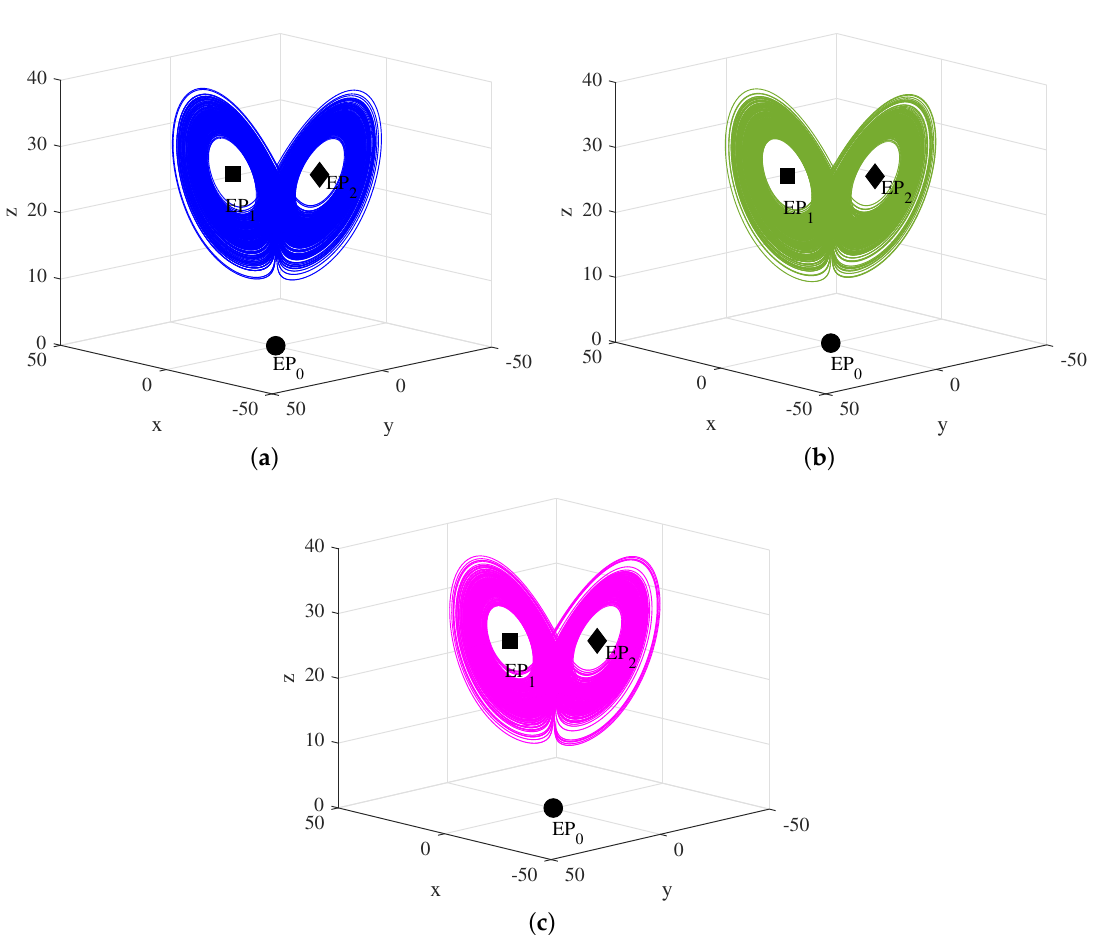
Figure 1. Phase diagrams in 3D plane for the optimized fractional order Chen system for each EA. ( a ) DE: equilib- rium points ( EP 0 , EP 1 , EP 2 ) = ([ 0,0,0 ] , [ 10.0612,10.0612,25.9081 ] , [ − 10.0612, − 10.0612,25.9081 ]) , ( b ) PSO: equilibrium points ( EP 0 , EP 1 , EP 2 ) = ([ 0,0,0 ] , [ 10.1513,10.1513,25.7959 ] , [ − 10.1513, − 10.1513,25.7959 ]) , and ( c ) IWO: equilibrium points ( EP ) = ([ 0,0,0 ] , [ 10.0749,10.0749,25.8950 ] , [ − 10.0749, − 10.0749,25.8950 ]) 0 , EP 1 , EP 2